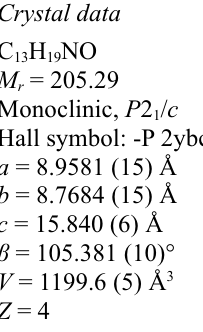
Dihedral angle of previously characterized aryl-substituted formamides N-(2,6-Diisopropylphenyl)formamide Crystal